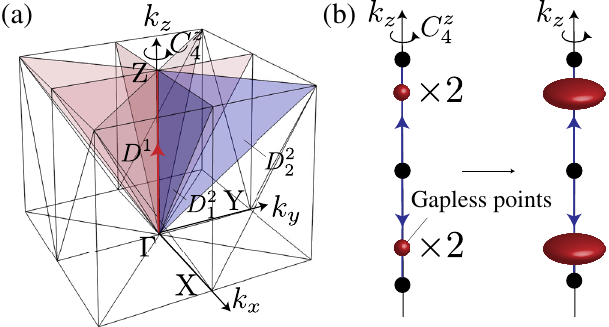
FIG. 15. (a) A half BZ in MSG P 4 . Here, the blue planes D 2 1 and D 2 2 are adjacent 2-cells to D 1 , and red ones are symmetry related to D 2 1 and D 2 2 . (b) Deformation of nodal structures in MSG P 4